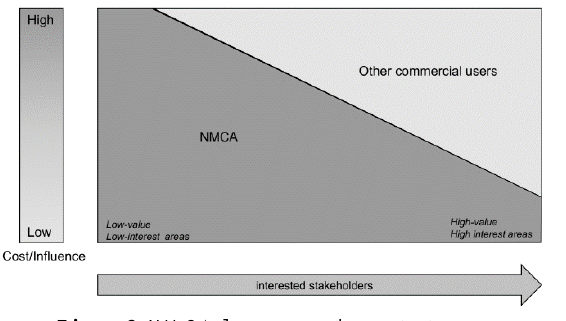
Figure 2 . NMCA leverage on the content program.